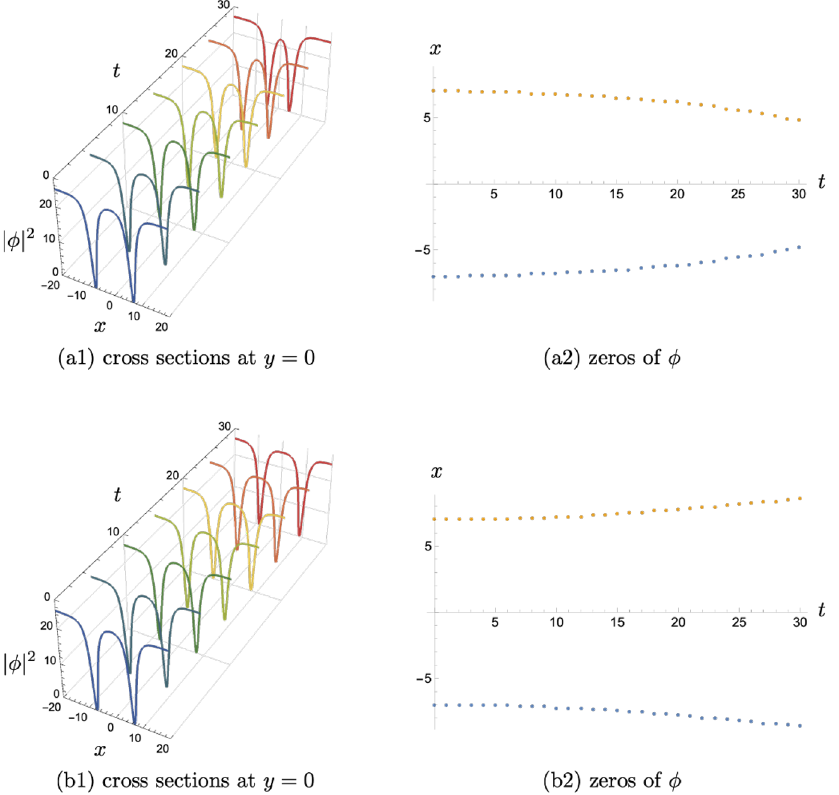
Figure 16 . The inter-vortex forces for the type I* non-Abelian vortices with ( m χ /m φ , m γ /m φ ) = √ (0 . 05 , 0 . 3) , or more explicitly ( v = 5 , λ = 1 / 4 , e = 3 / 10 2 , Ω = 1 / 4 ). Panels (a1) and (a2) correspond to parallel vortices, whereas panels (b1) and (b2) correspond to anti-parallel vortices. Panels on the left show the time evolution of | φ | 2 (cross sections at y = 0 ), while panels on the right present the x -position of the vortex centers from t = 0 to t = 30